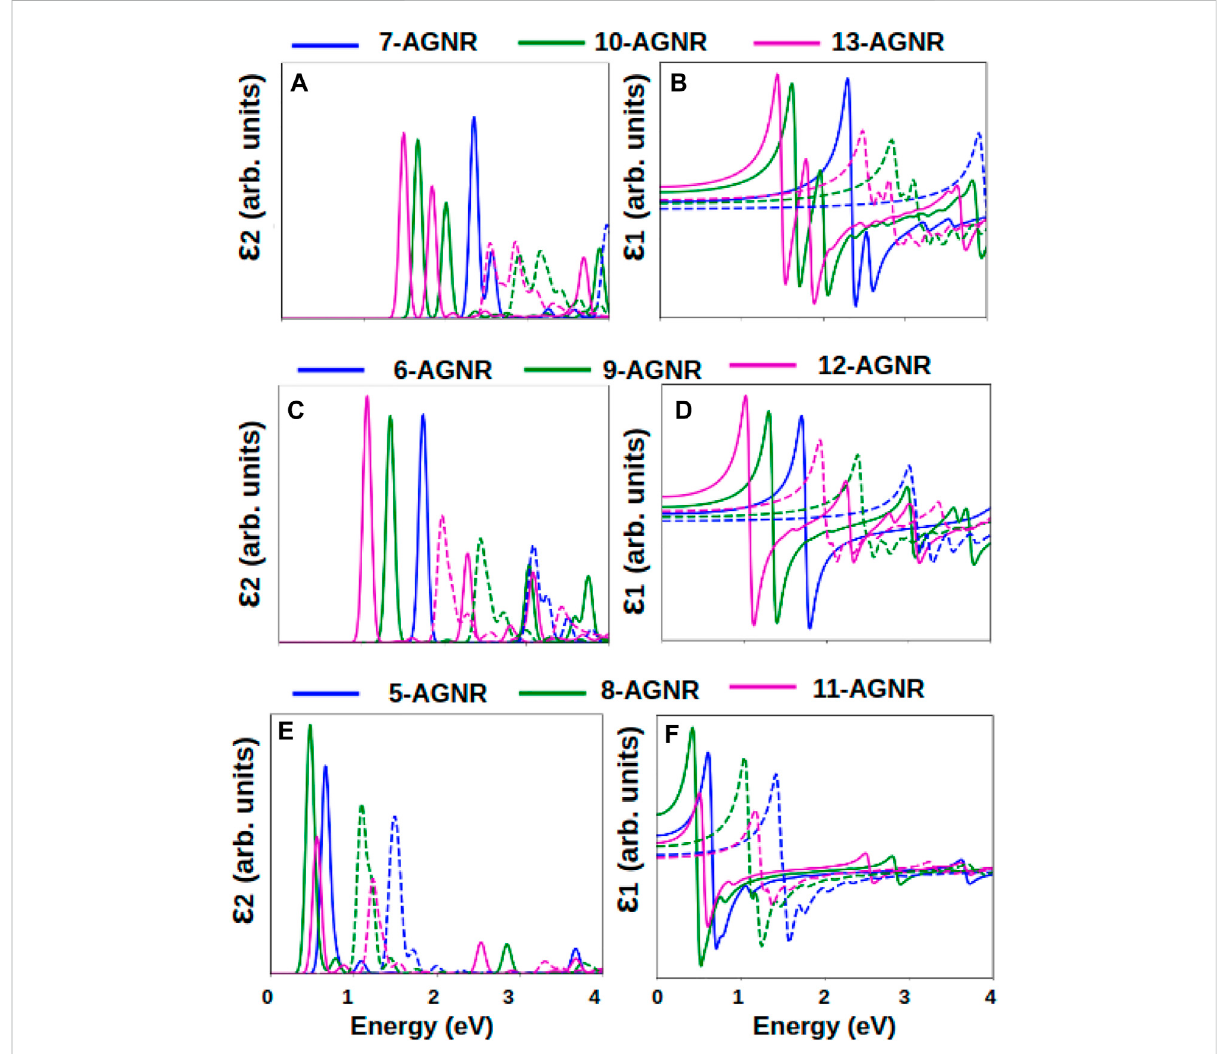
Mean- fi eld ground-state electronic structure was calculated using the Quantum Espresso package (Giannozzi et al., 2009). Full potentials were replaced by norm-conserving pseudopotentials with a 110 Ry cutoff to reduce the oscillation of wave functions and therefore the number of plane waves near the core. Exchange- correlation potentials were accounted for within the local density approximation (LDA) (Perdew and Wang, 1992). The atomic structures were fully relaxed using a 1 × 1 × 30 k-grid until the energy error between two consecutive self-consistent calculations was smaller than 10 – 12 Ry .